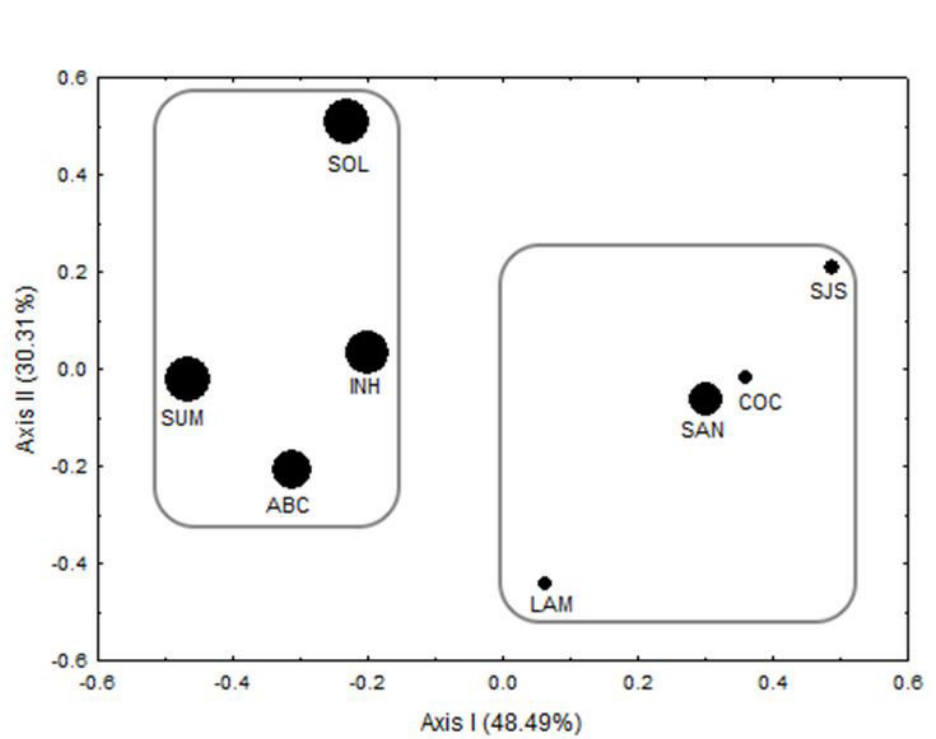
Figure 2. Ordination of the composition of odonate species from the streams of Caxias, Maranhão, Brazil, based on a Principal Coordinate Analysis (PCoA). The size of the points represents the value of the Habitat Integrity Index. Streams: Areia Branca (ABC), Cocos (COC), Inhamum (INH), Lamego (LAM), São José (SJS), Sanharó (SAN), Soledade (SOL), Sumidouro